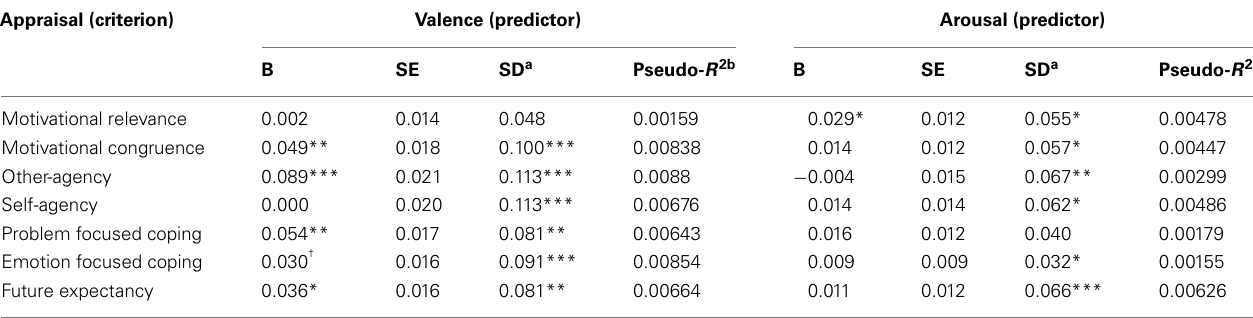
Table 3 | Results from cross-lagged multilevel regression analyses predicting change in appraisal based on lagged valence or arousal. Appraisal